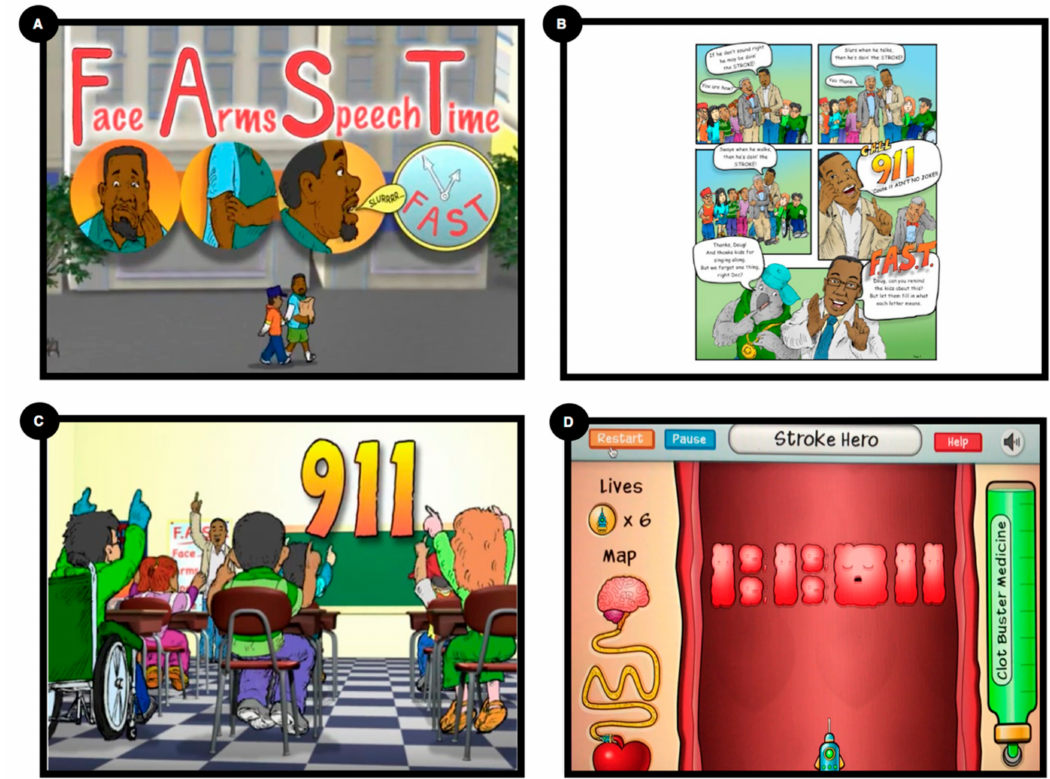
Figure 3. Sample Hip Hop Stroke Media. ( A ) “Keep Your Brain Healthy”—animated feature showing the Facial drop, Arm weakness, Speech slurring/disturbance, and Time to call 911 (F.A.S.T.) mnemonic; ( B ) Hip Hop Stroke Comic Book; ( C ) “Stroke Ain’t No Joke”—animated feature; and ( D ) “Clotbuster” video